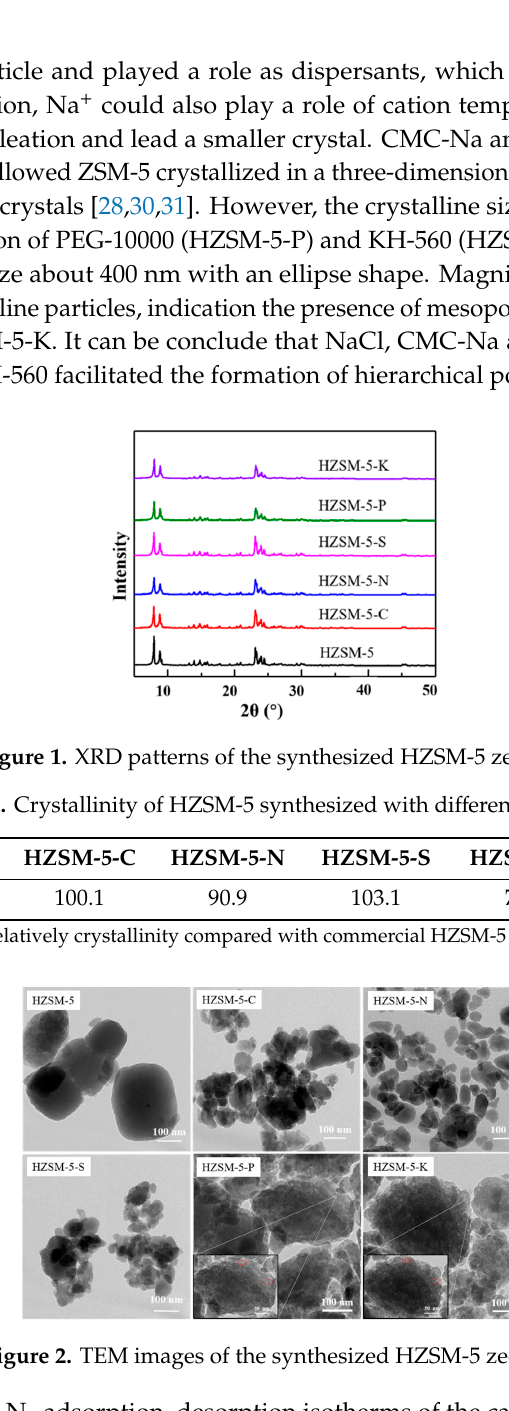
Figure 2. TEM images of the synthesized HZSM-5 zeolites.